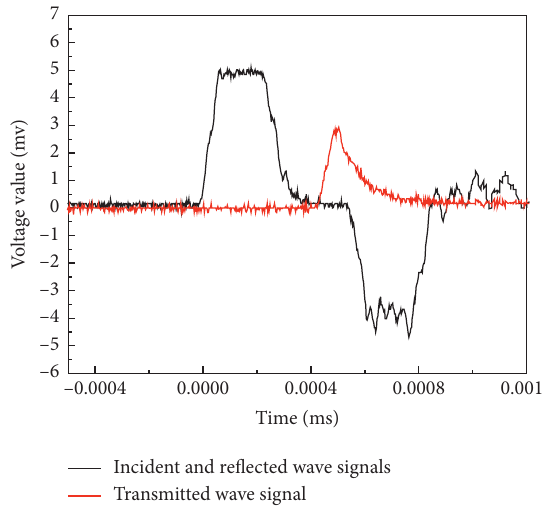
Figure 4: Loading waveform of the improved SHTB adhesive